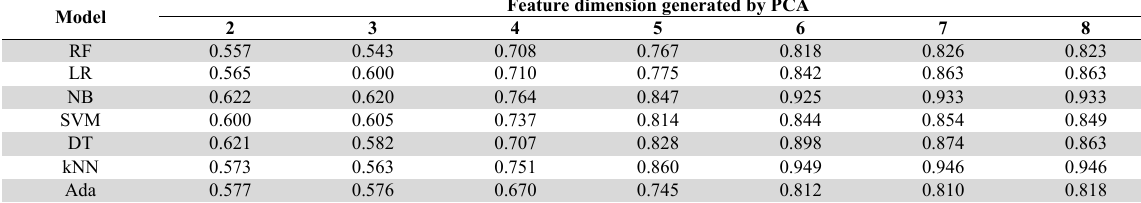
Results of F1 evaluation measure against different feature dimensions generated by PCA Model